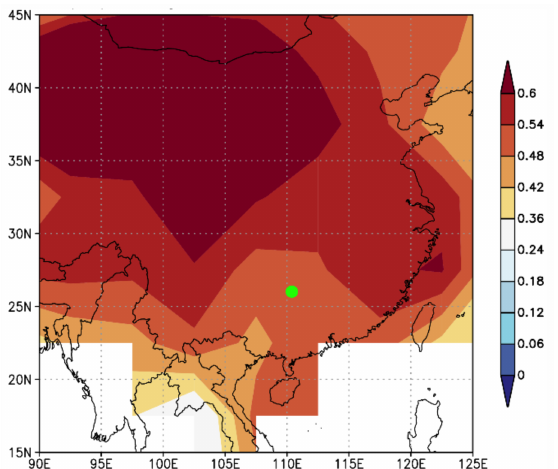
Figure 7. Spatial correlations between the reconstructed pMar-pOct mean temperature and the NCDC gridded temperature during 1958–2016. The green dot denotes the MRS site in this study. Shading denotes the correlations that are statistically significant at the 0.10